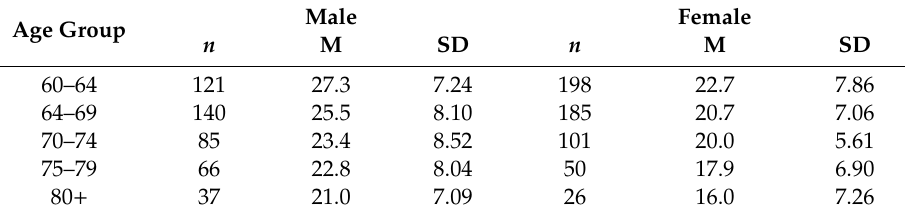
Table 11. One-minute sit-to-stand based on age group and gender, Unit: reps. Age Group